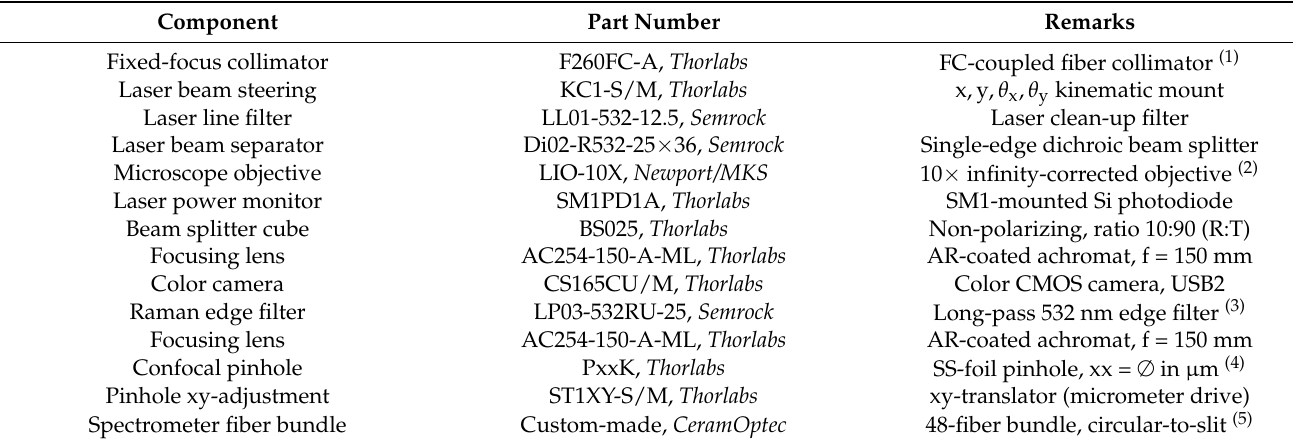
Table 1. Specification of key optomechanical and optical components used in the current confocal Raman microscope (CRM)